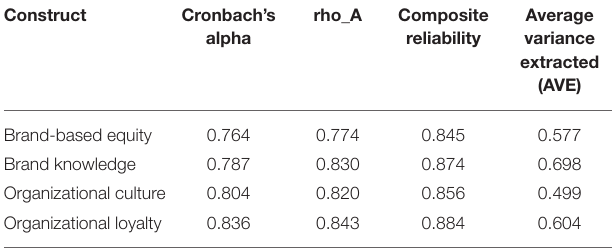
TABLE 1 | Reliability and validity.